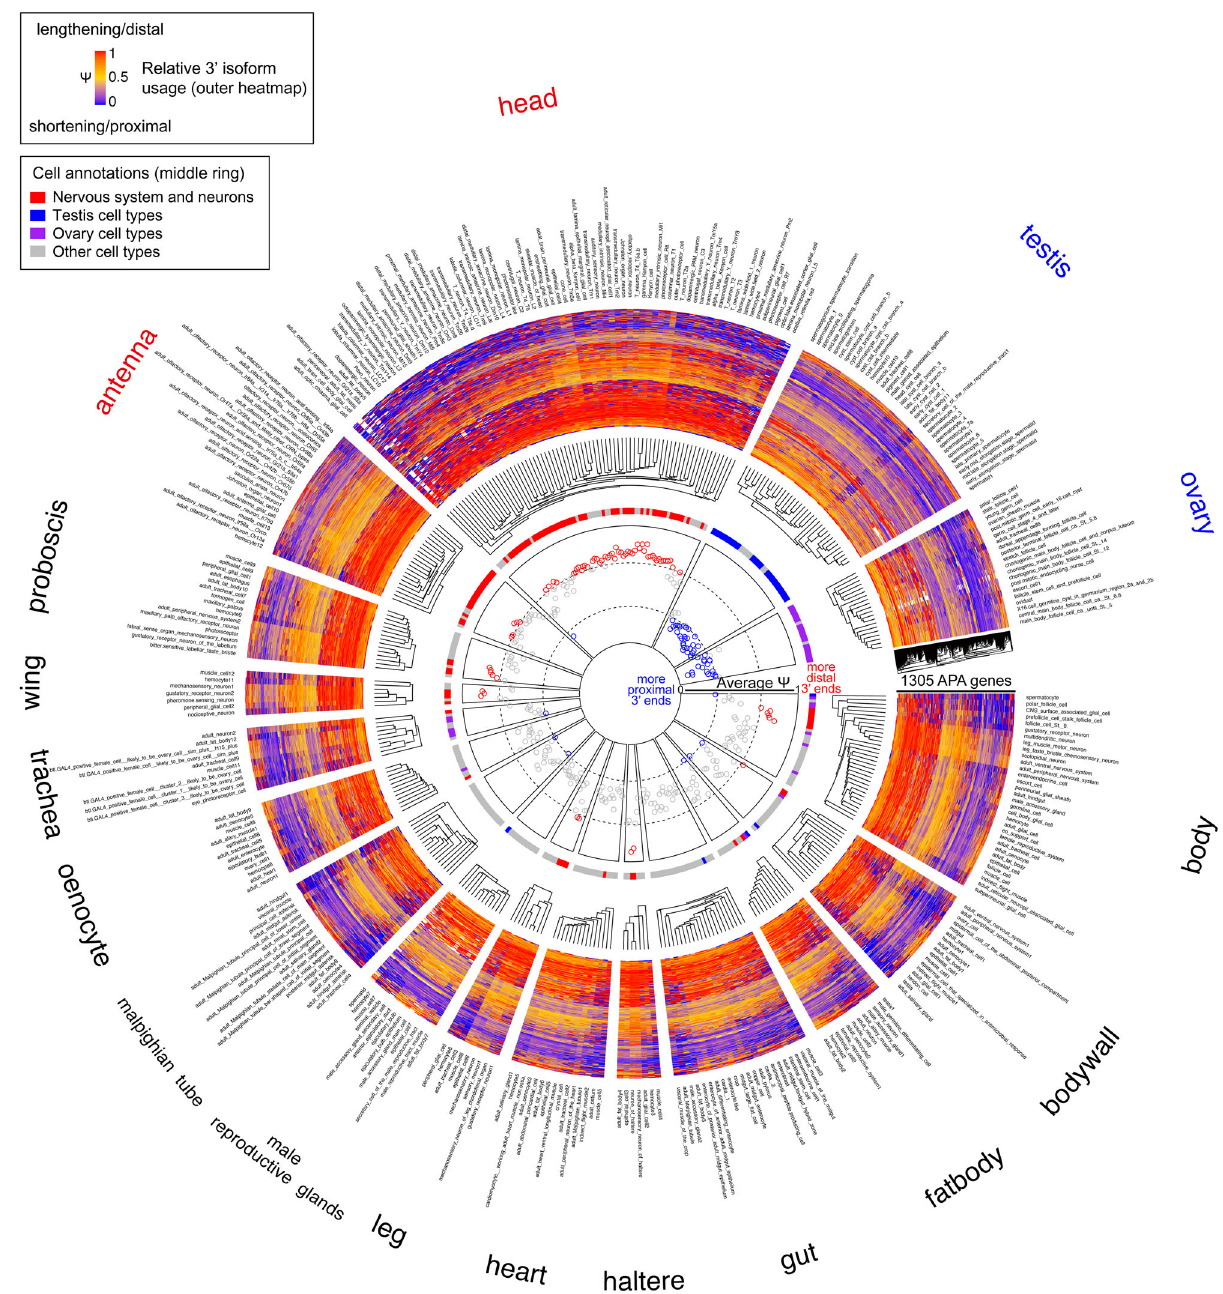
Fig. 2 | Summary ofglobal 3 ’ UTR utilization across ~250 Drosophila cell types. ThecircularplotsummarizesAPAtrendsacross1305genesthatexhibitdifferential 3 ’ UTR utilization from neurons, ovary, and testis cells. We used the LABRAT package to calculate ψ across these genes in each of the 242 adult Drosophila cell types annotated by the FCA, grouped according to their tissue origin. Because somecelltypesare found inmultiple tissues,the numberofsectorsisgreater than 242 (e.g., musclecells, epithelialcells, hemocytesand fat body are present broadly across tissues). We describe the plot features from outside in. The tissue and cell types are shown at the perimeter. Inside this, the behavior of individual genes is